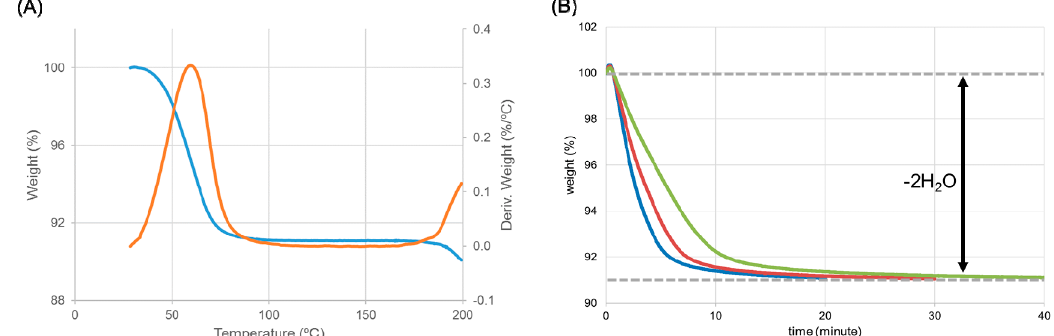
Figure 8. Identification of the intermediate using thermogravimetric analysis. ( A ) The thermogravimetric analysis (TGA) curve (blue) was overwritten by the derivation of the TGA curve (orange). ( B ) Change in weight (%) at different temperatures: 40 °C (green), 45 °C (red), and 50 °C (blue). The magnitude of weight loss (about 9%) was equivalent to the weight of water in the dihydrate.